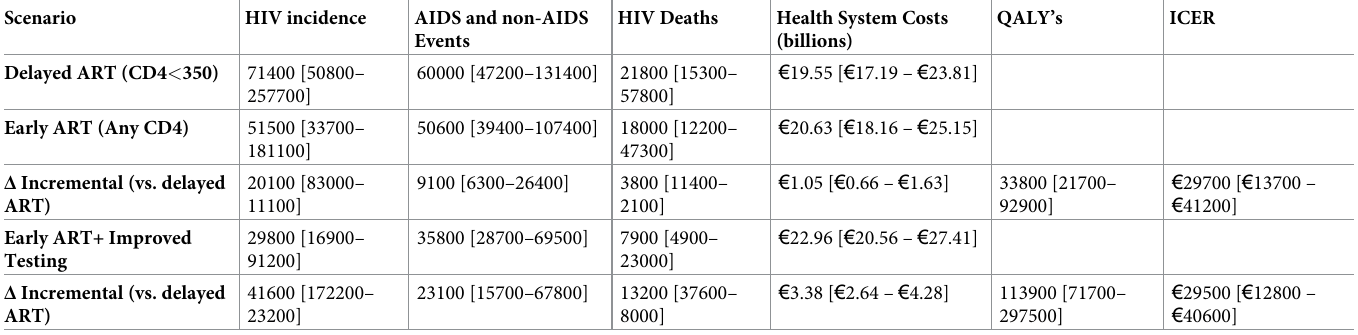
Table 2. Costs and effectiveness of selected ART initiation scenarios in Spain over the next 20 years. All outcomes represent the median [95% uncertainty ranges] across simulations. Future costs and QALY’s are discounted.